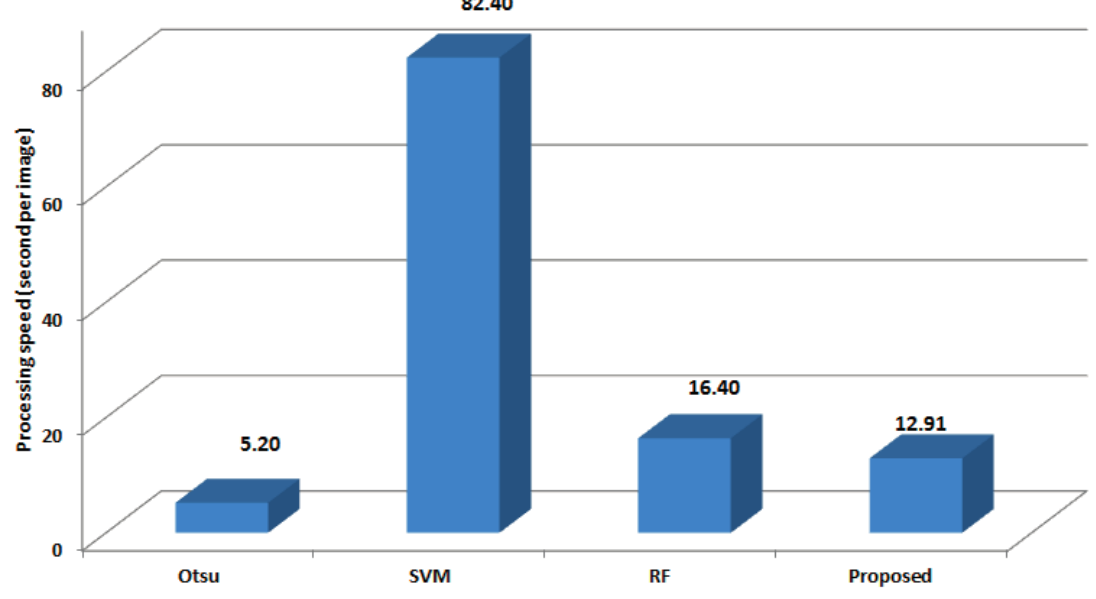
Figure 5. Comparison of processing speeds between proposed method and two related works.